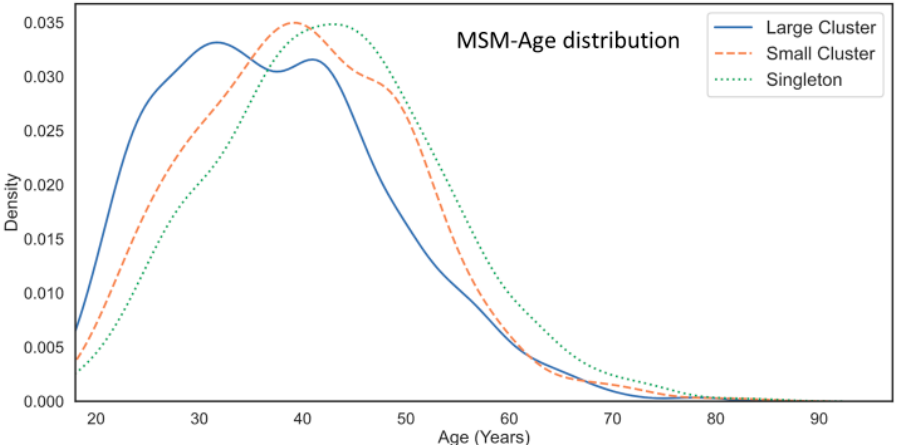
Figure 8. Age distribution of MSM participants in singleton, small, and large cluster networks. Kernel plots reveal the bimodal age distribution for large cluster networks.